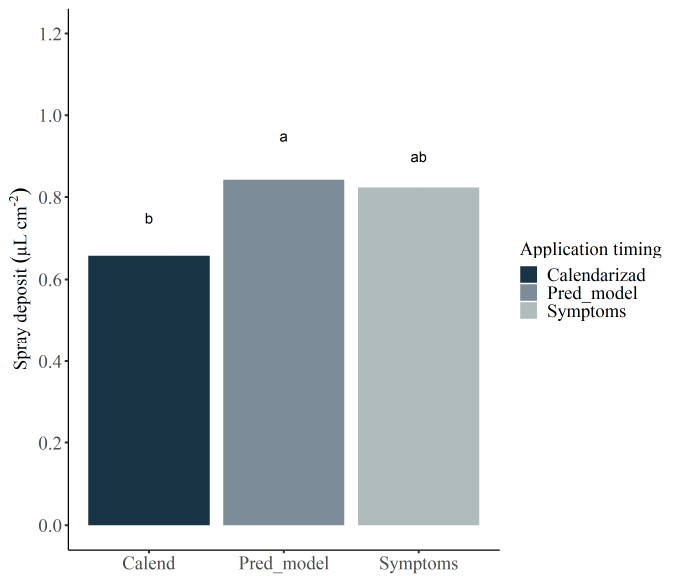
Figure 8. Mean deposit values ( µ L cm − 2 ) that were collected in the upper region of the soybean canopy at different application timings in the first application of Field 2. The means followed by the same letter did not differ by the Tukey’s test at 5% probability ( p < 0.05).